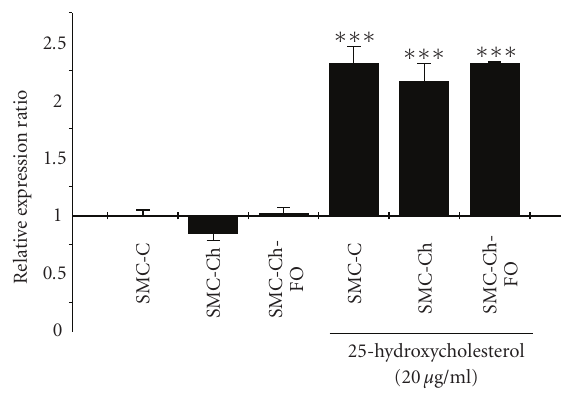
Figure 2: Representative Western blots showing expression levels of Bax, Bcl-xl, and Bcl-2 on SMC cultures at baseline (SMC-C, SMC-Ch, and SMC-Ch-FO) and changes in protein expression after treatment of SMC cultures with 20 μ g/mL 25-hydroxycholesterol for 24 hours. Equal amounts of proteins were separated by electrophoresis and processed for immunoblotting. Similar results were obtained in three separate experiments. The ratios were calculated by using O.D protein band reading and normalized against a control (SMC-C) for each protein.